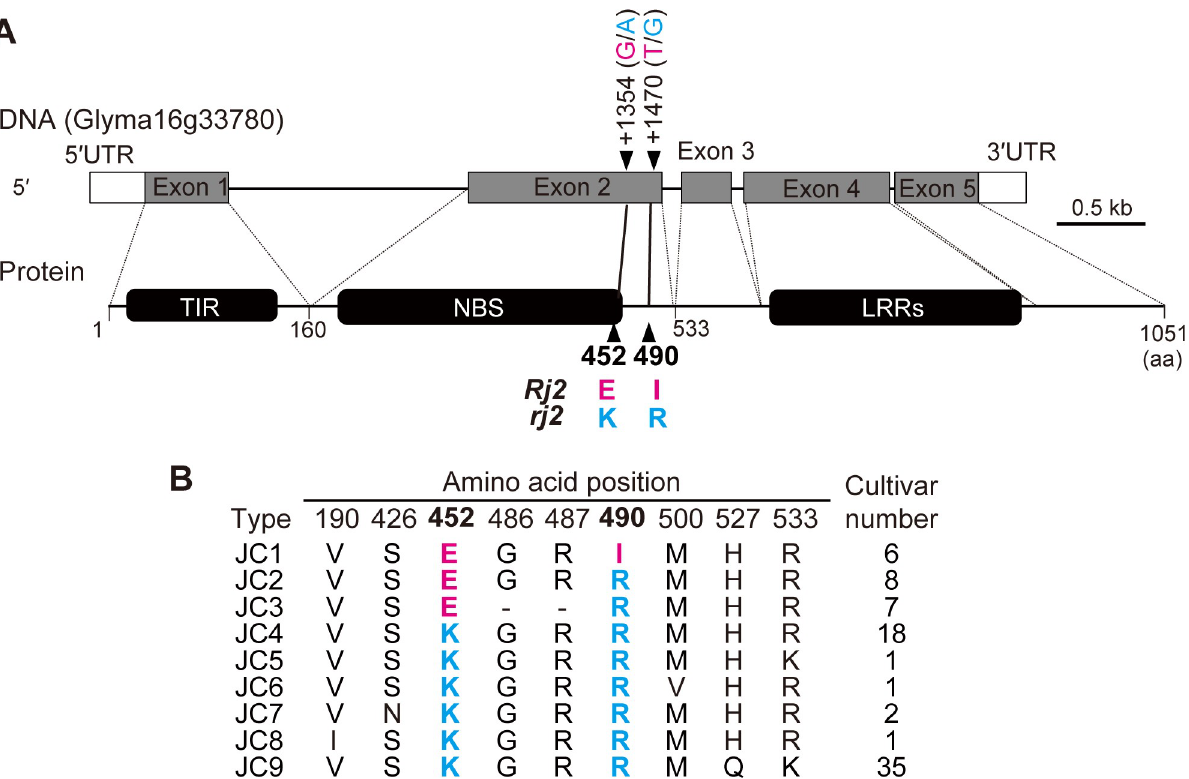
Fig 1. The structure of the Rj2 gene and amino acid polymorphisms in a Japanese soybean mini-core collection. (A) Structure of the rj2 allele (Glyma16g33780) in the model soybean ‘Williams 82’. The gene consists of five exons (Exon 1 to Exon 5), and encodes a TIR-NBS-LRR class resistance protein. The residues at positions 452 and 490 are encoded by Exon 2. Numbers and nucleotides following the arrowhead on Exon 2 indicate the SNP position on the rj2 cDNA (Accession No. GU 967692) and also indicate the nucleic acids involved in the differences in amino acid residues at 452 or 490. The Rj2 - and rj2 -type amino acids or nucleotides are shown in magenta and cyan letters, respectively. (B) Allelic comparison of the 79 soybean accessions in the Japanese mini-core collection. Amino acid sequences of each cultivar were deduced from the Exon 2 region in the alleles.